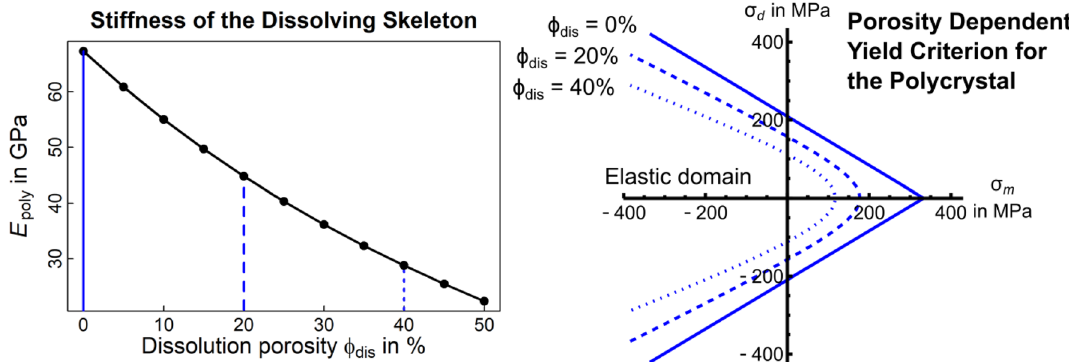
Figure 7. Impact of ocean acidification on cold-water coral skeletal stiffness and strength: Left, the effect of increasing porosity due to ocean acidification on the stiffness of the polycrystalline CWC skeleton. Small increases in porosity significantly lower the ability of the skeleton to resist external loading. Right, increasing porosity due to ocean acidification significantly lowers the limit bearable load the dead skeleton can withstand so that much lower loads are needed to break the CWC